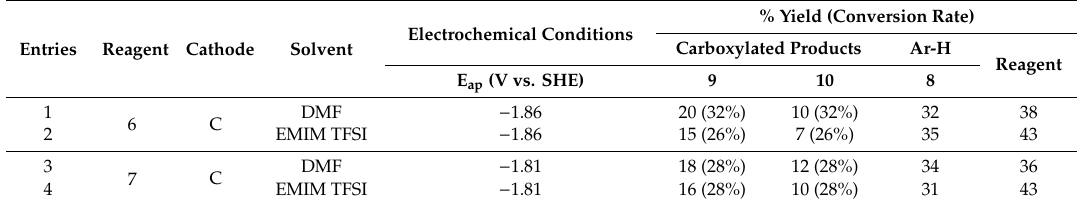
Table 5. Results of the electrocarboxylation of 6 and 7 at 2F.